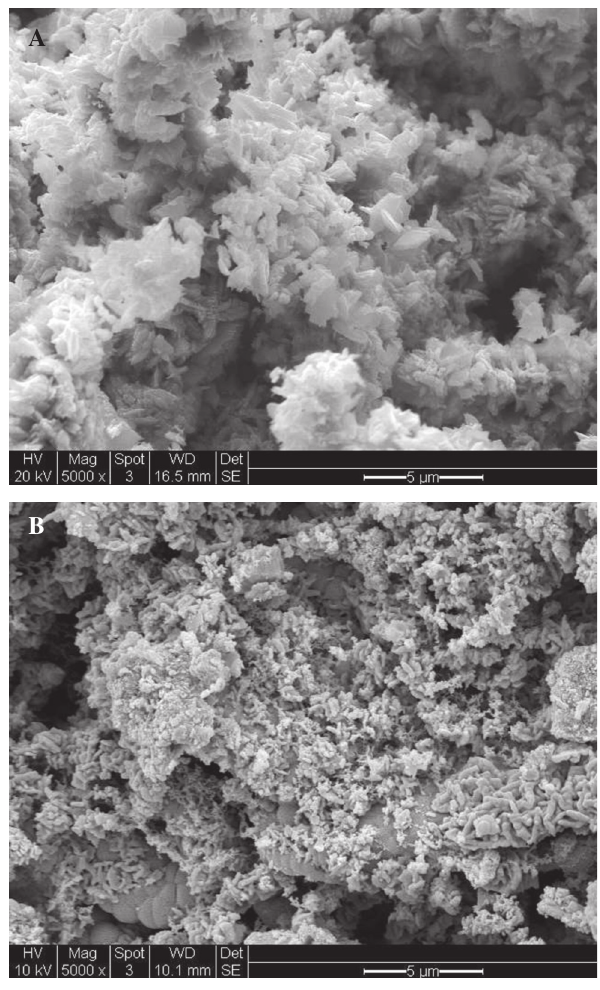
Figure 2 SEM images of supported Cu/Co catalyst samples. (A) fresh catalyst; (B) after reaction in